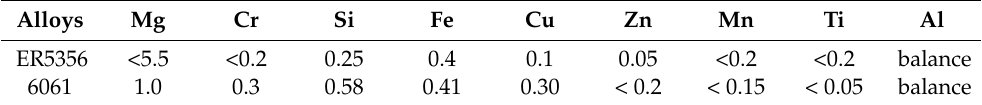
Table 1. Chemical composition of ER5356 welding wire (mass fraction, %).